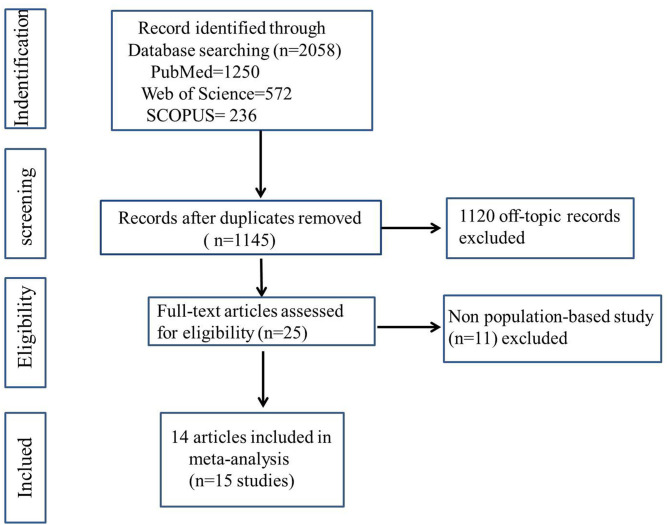
Flowchart of study identification for meta-analysis.